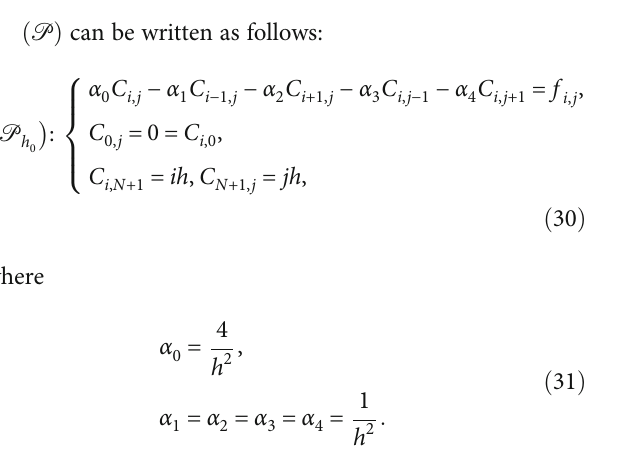
Figure 1: Approached solution of fi nite di ff erence method when N = 10, h = 1/11 , and k = 5